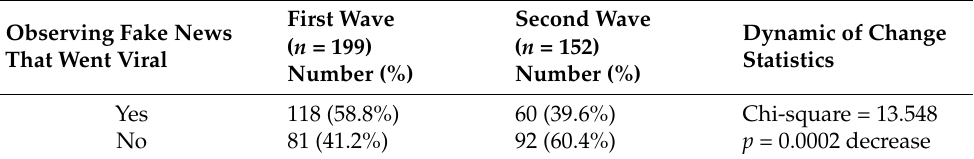
Table 3. Fake news related to COVID-19 going viral on social